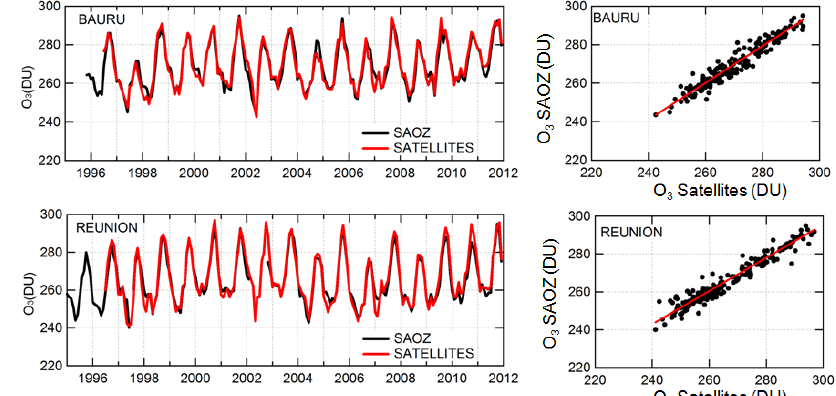
Figure 7. Left: Time series of SAOZ (black) and merged satellites (red) total O 3 column (DU) in Bauru (top) and Reunion (bottom). Right: Correlation between SAOZ and merged satellites ( r 2 = 0.96 in Bauru and r 2 = 0.97 in Reunion).